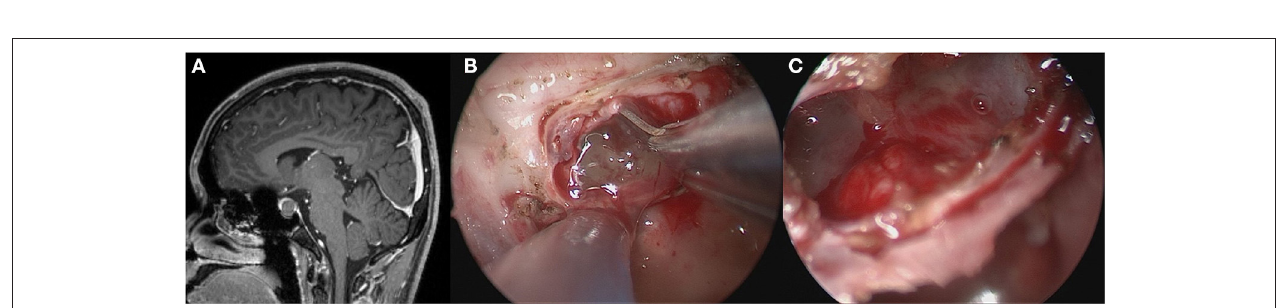
FIGURE 2 | Partially resection of the cyst wall. (A) Preoperative contrast-enhanced MRI showed a cystic mass within the sella. (B) Exposed the gelatinous contents after opening the bottom of the saddle. (C) No further cleaning was done after the gelatinous contents were sucked out.